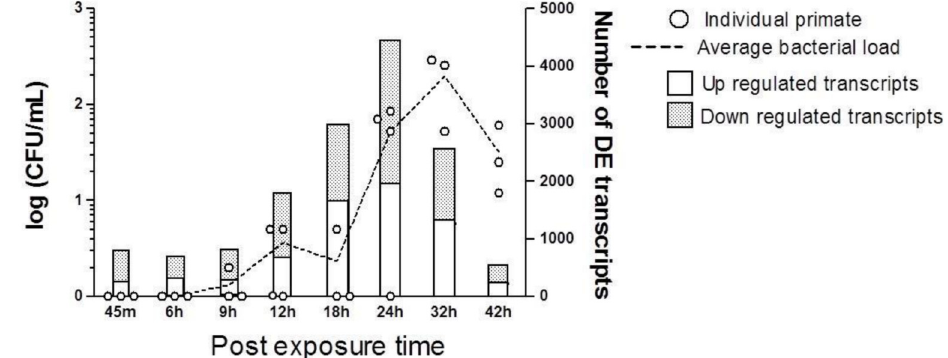
Fig 1. Longitudinal shift of bacteria load in nonhuman primates ’ blood and corresponding transcriptional profile. The CFU/mL on the Y-axis (left side) is in log scale. The circles indicate the bacterial load of each animal and the dotted line connects the mean bacterial load across the course of infection. The transcriptomic profile (GoI- Time ) across the course of infection is also shown on the right side Y-axis. The bars showing the differentially expressed transcripts are divided into up- and down-regulated